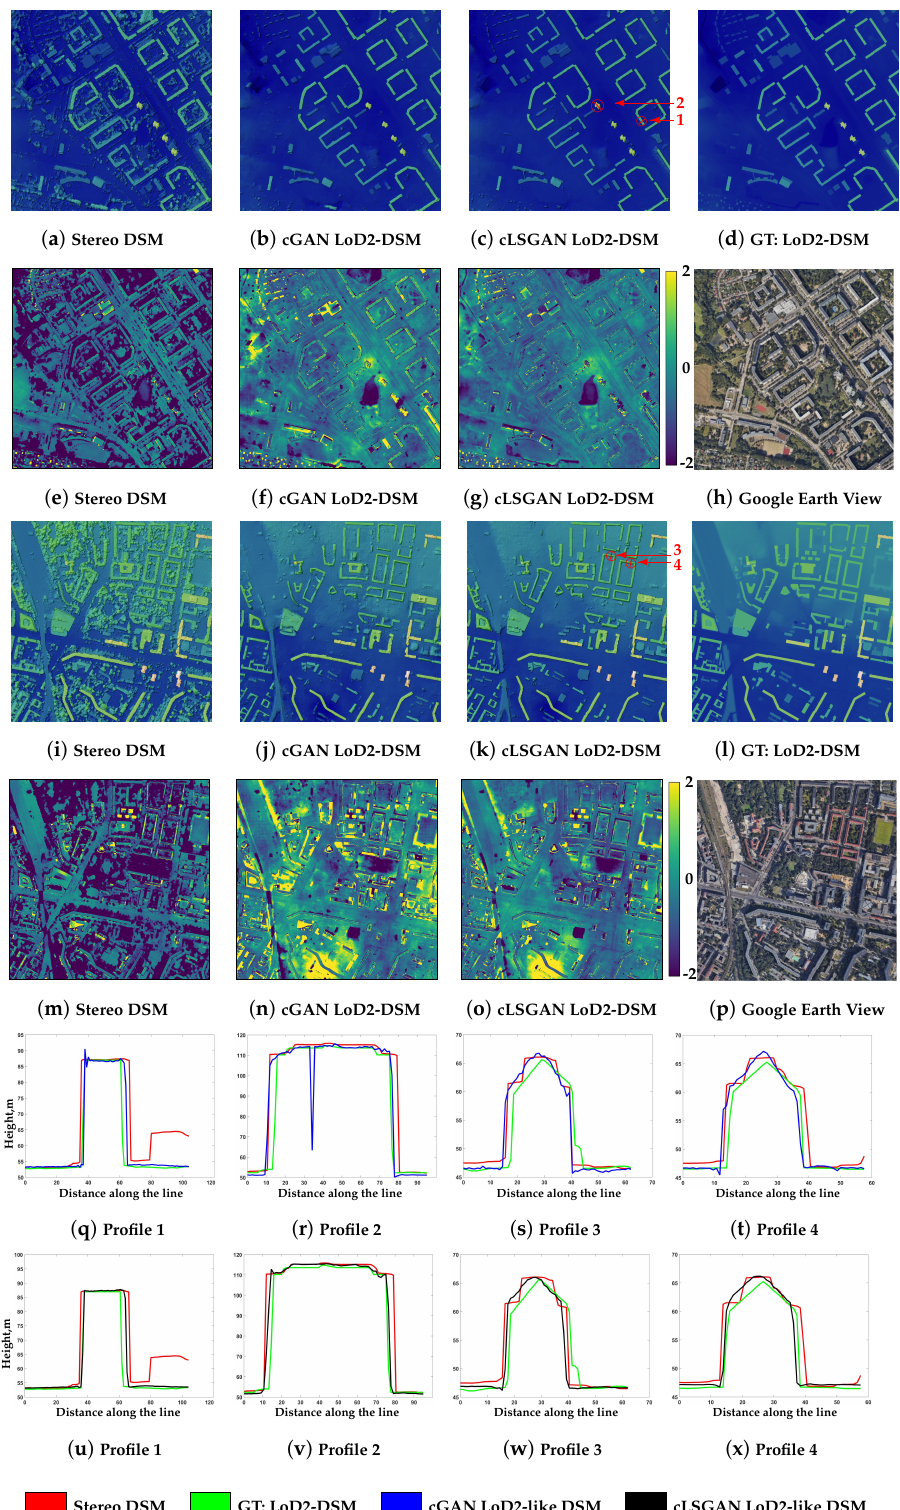
Figure 5. Visual analysis of DSMs, generated by cGAN and cLSGAN architectures, over selected urban areas. The DSM images are color-shaded for better visualization. Difference maps in meters of stereo and generated DSMs with respect to the ground truth LoD2-DSM of the selected regions are shown in the second and fourth lines, respectively. The profiles of selected buildings from DSM generated by cGAN are illustrated in the fifth line, and the ones from cLSGAN are in the sixth